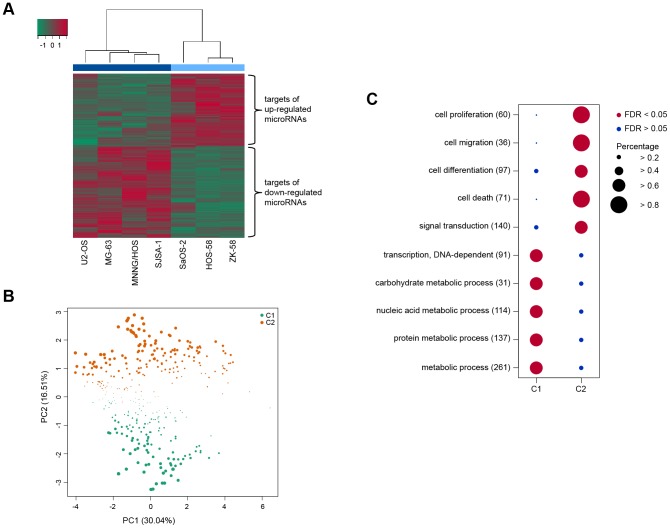
Functional implications of microRNA target genes in OS proliferation.(A) Differentially expressed microRNA target genes. The heatmap shows the expression of DE microRNA target genes (log2 FC≥|0.7| & p-value<0.05, y-axis) among all OS cell samples (x-axis). High (dark blue) and low (light blue) proliferative OS samples are grouped into distinct clusters. The red/green color code corresponds to the expression deviation from the average expression among all samples. Complete-linkage clustering was applied with the Pearson correlation as distance metric. (B) Principal component analysis based on GO functional similarity. The figure draws the first (x-axis) and second (y-axis) principal components based on the GO functional similarity of microRNA target genes. The target genes are color coded according to their cluster membership determined by FCM. The radius of each gene represents the strength of association to its cluster. (C) Comparison of the GO enrichment analyses of the distinct clusters. Each row corresponds to a specific biological process category. The number of genes included in each category is indicated in the round brackets. Circle sizes correspond to the percentage of row-genes located in a cluster. Significantly enriched categories are color coded in red and random categories in blue.